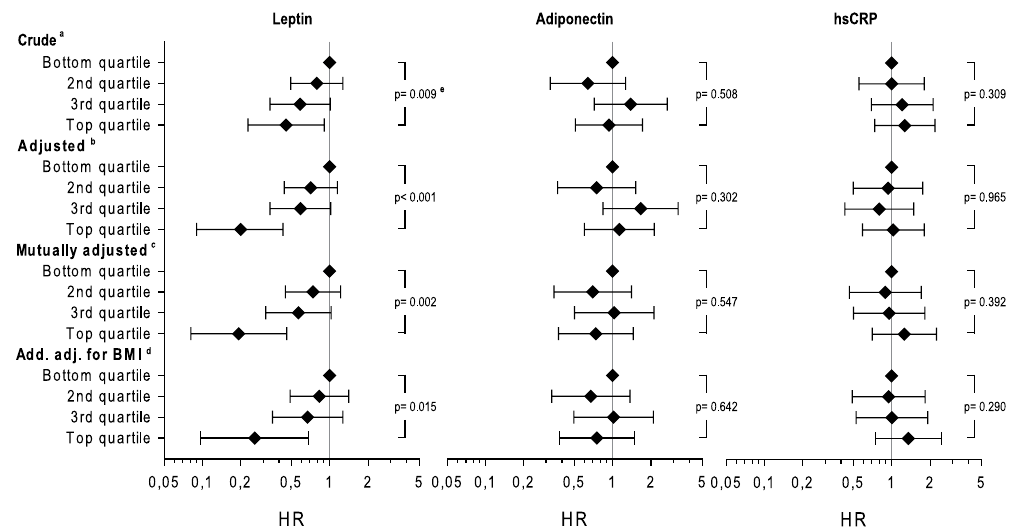
Figure 2. Hazard ratio for mortality by sex specific quartiles of leptin, adiponectin and hs-CRP serum concentrations among 279 ALS patients. a Stratified for age and sex. b additionally adjusted for age, diagnostic delay, site of onset and ALS-FRS. c as b but mutually adjusted for leptin, adiponectin and hsCRP. d as c but additionally adjusted for Body mass index (BMI). e P-values indicate trend over